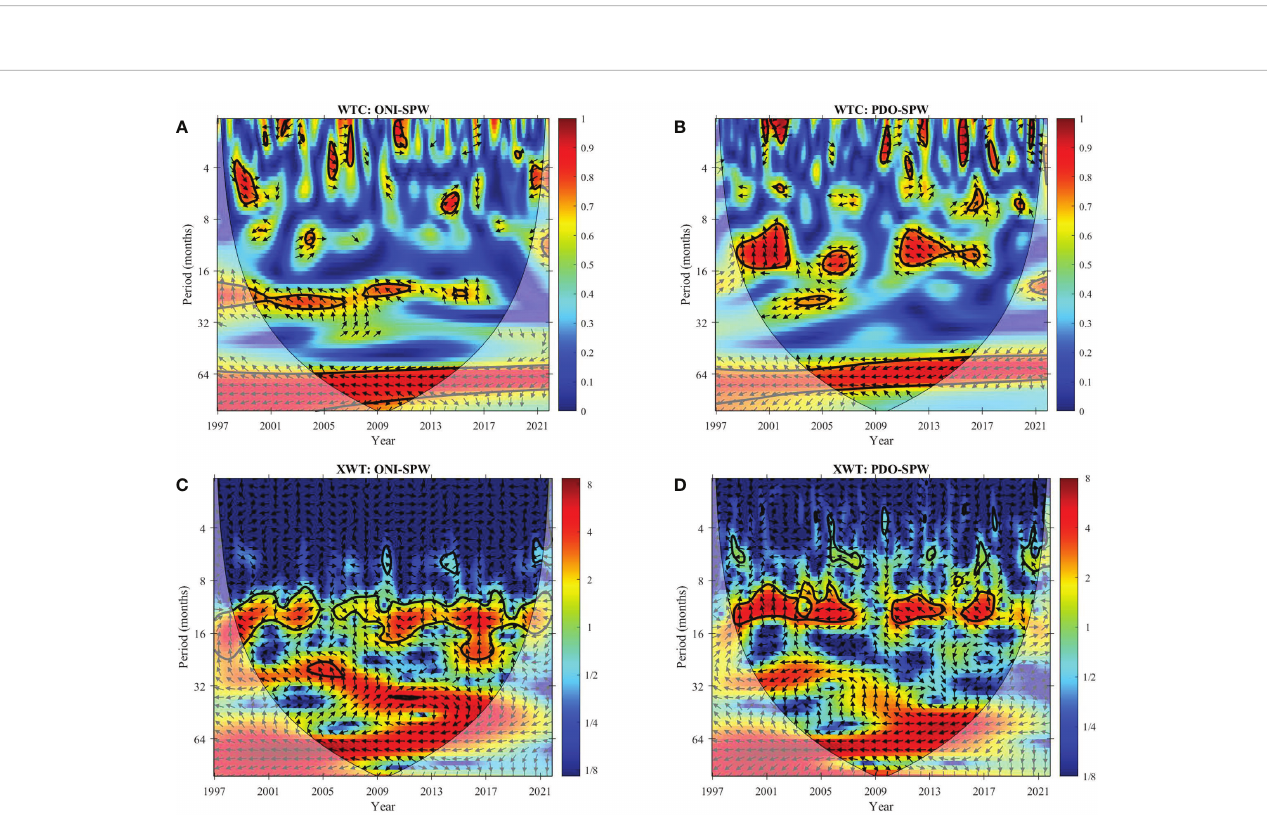
FIGURE 11 WTC and XWT spectrum of ocean-atmosphere variabilities and the RSL at SPW site. (A, B) are the WTC spectrums of ONI-SPW and PDO-SPW. (C, D) are the XWT spectrums of ONI-SPW and